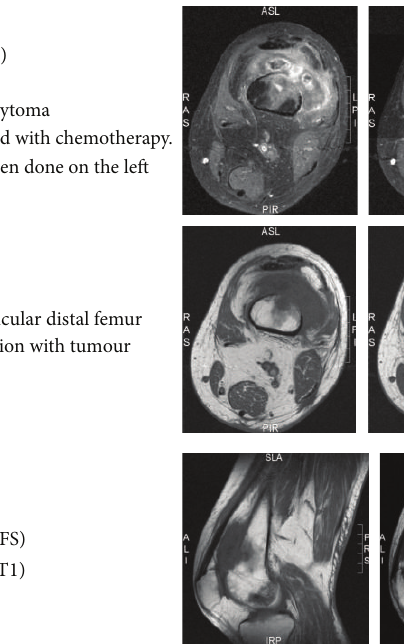
Figure 2: Example case as given to the orthopedic oncologists. This is patient 7 in Table 1.